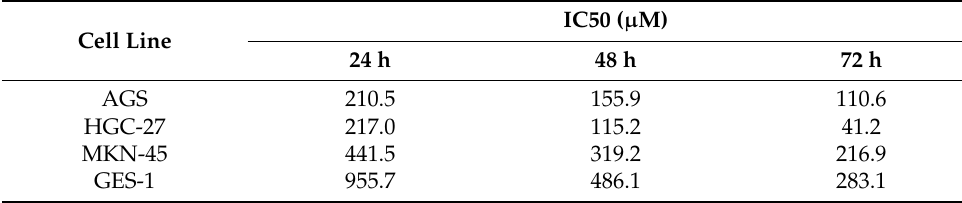
Figure 1. Inhibition of cell viability of gastric cancer (GC) cells by eriodictyol, quercetin, taxifolin, and kaempferol. ( A ) Cell inhibition by eriodictyol, quercetin, taxifolin, and kaempferol of AGS and HGC-27 cells was determined by CCK-8 assays. ( B ) Cell inhibition by eriodictyol of MKN-45 cells was determined by CCK-8 assays. ( C ) Cell inhibition by eriodictyol of GES-1 cells was determined by CCK-8 assays. ( D ) The chemical structure of eriodictyol. Three independent experiments were performed, and data are presented as mean ± SD. Table 1. IC50 of eriodictyol of GC cells and gastric epithelial GES-1 cells.